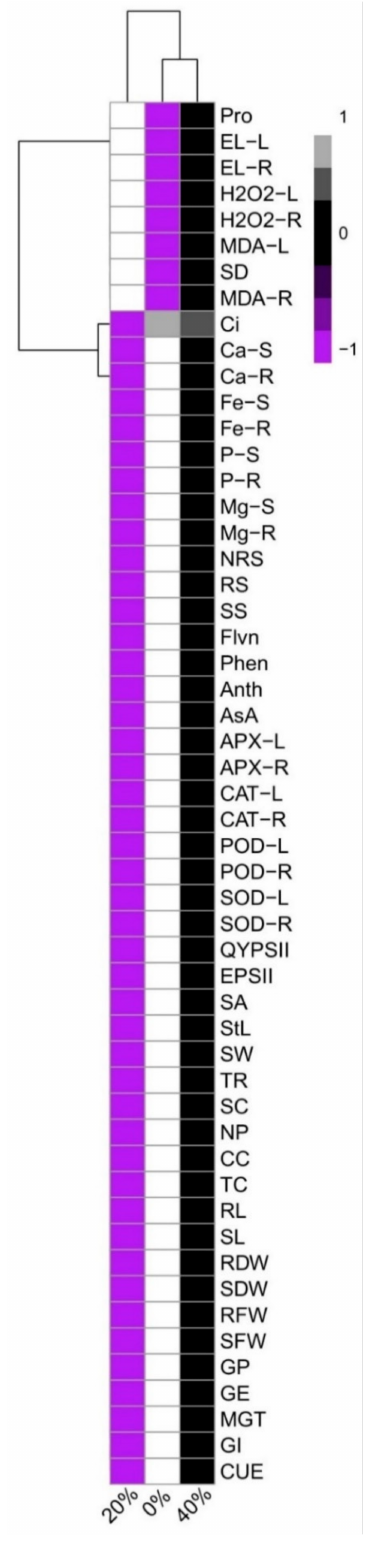
Figure 10. Heatmap histogram correlation between different studied attributes of Zea mays grown under water stressed and non-stressed environment Different treatments ( P. ovata extract) used in this study are as follows: 0% (0% P. ovata extract), 20% (20% P. ovata extract) and 40% (40% P. ovata extract). Different abbreviations used are as follow: Pro (proline contents), EL-L (electrolyte leakage in the leaves), EL-R (electrolyte leakage in the roots), H2O2-L (hydrogen peroxide initiation in